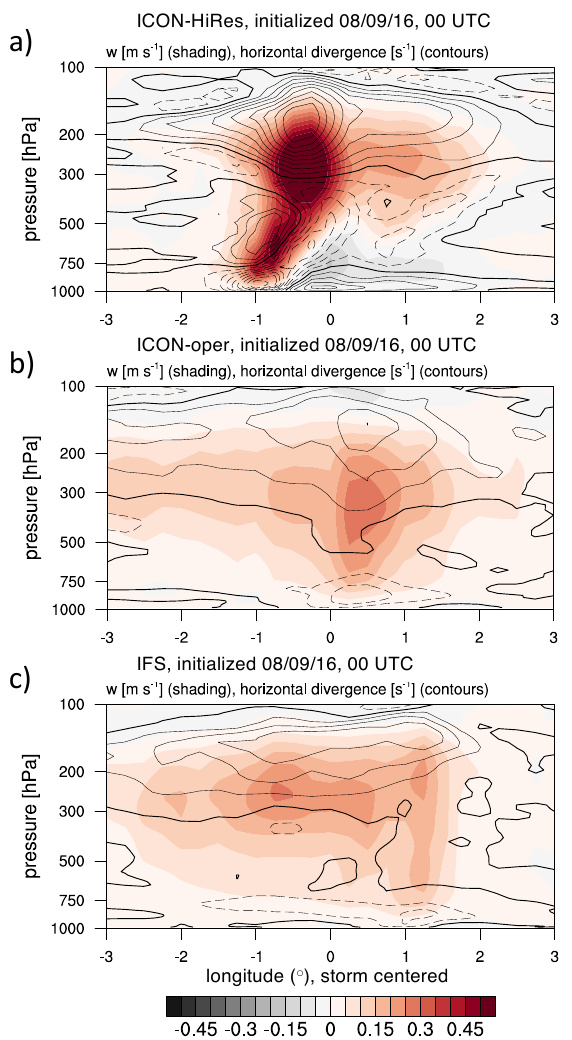
Figure 7. Storm-centered zonal cross-sections of vertical velocity (m s − 1 ) (shading) and horizontal divergence (s − 1 ) (contour lines; positive thin solid, zero line thick solid, negative dashed; regular spacing of 2 × 10 − 5 s − 1 ): ( a ) ICON-HiRes; ( b ) ICON-oper; and ( c ) IFS. The fields are 2 ◦ meridionally